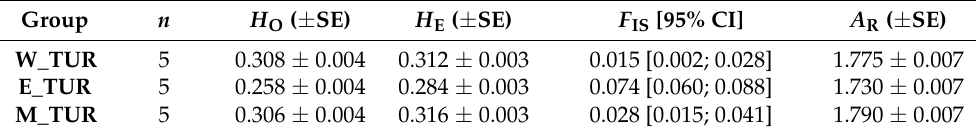
Table 2. Genetic diversity in the groups of Caucasian tur ( Capra caucasica ).